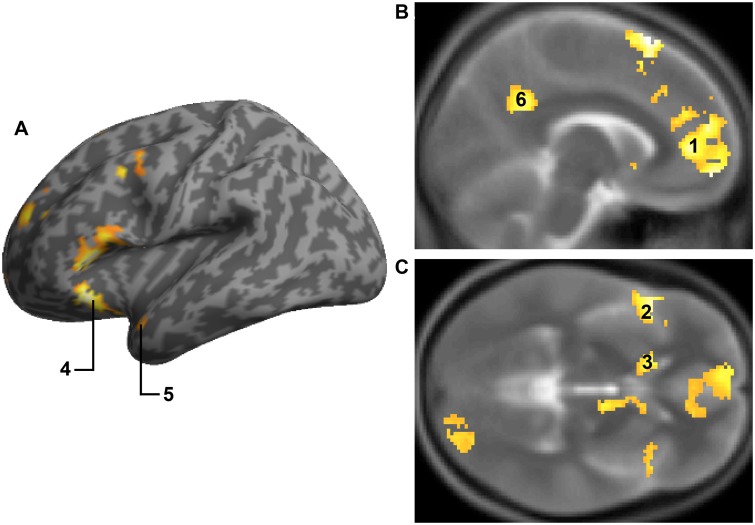
Results of the guilt memory/guilt hypothetical contrast. Effects are thresholded at p < 0.001, with a minimum cluster-size of 23 voxels. (A) Left hemisphere showing increased activity of the OFC (4) and the temporal pole (5). (B) Sagittal view showing increased activity of ACC (1) and the precuneus (6). (C) Axial view showing increased activity of the insula (2) and the caudate nucleus (3).